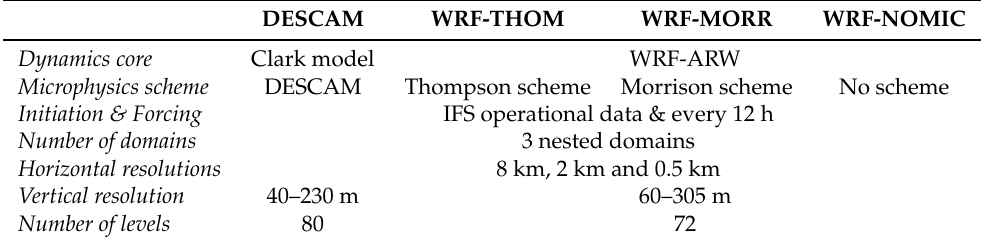
Table 2. Description of the model domain configuration as well as initiation and forcing conditions for DESCAM, WRF-THOM, WRF-MORR and WRF-NOMIC